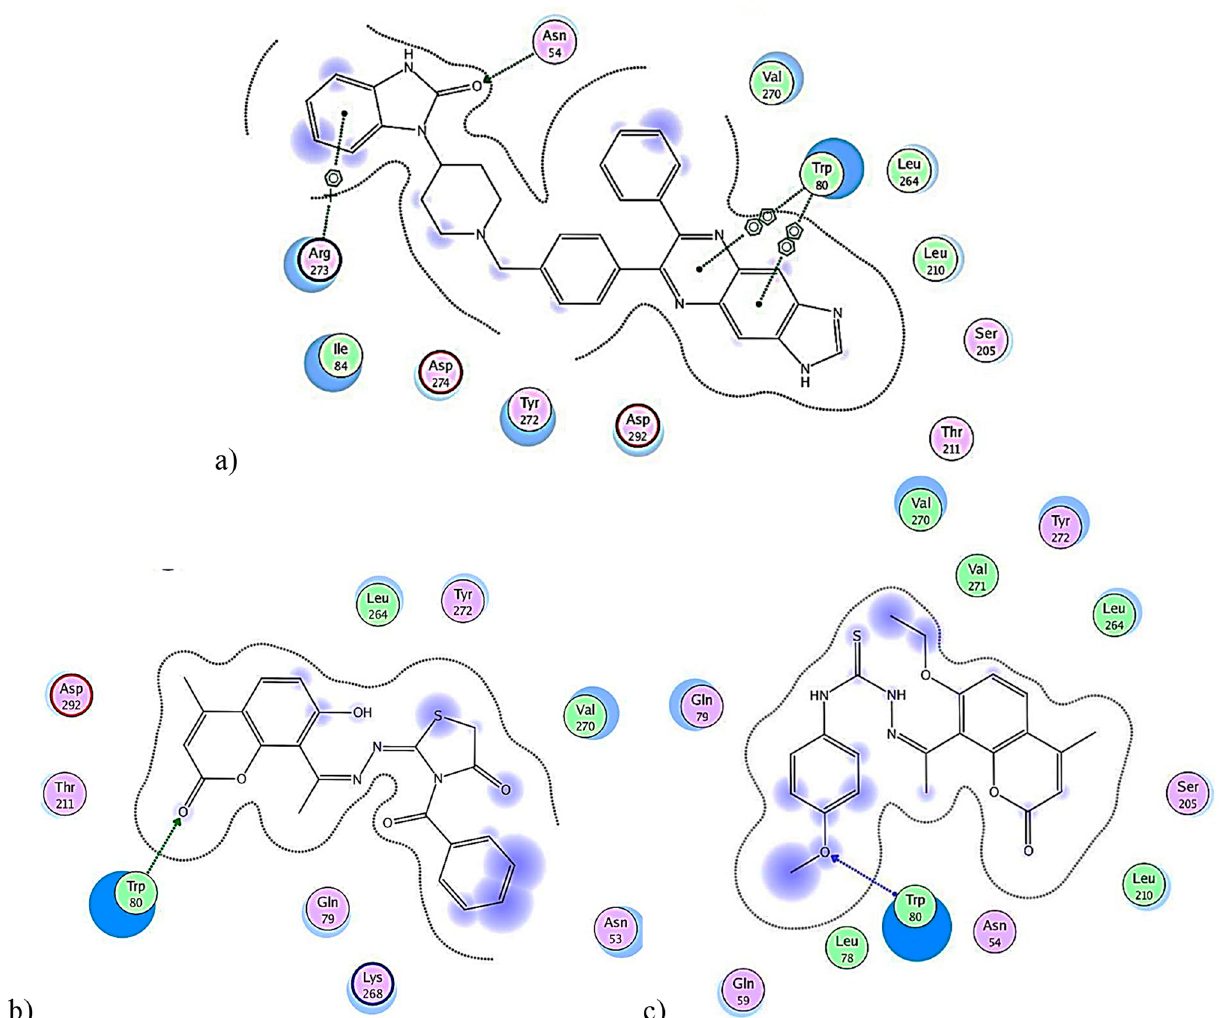
Figure 8. The 2D binding patterns of compounds: ( a ) IQO reference ligand; ( b ) VIIb ; ( c ) VIf in the active site of Akt.